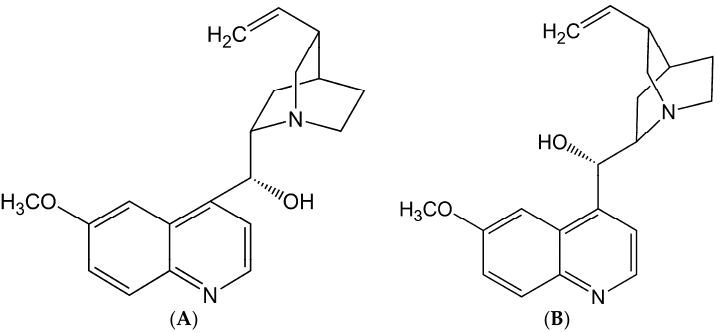
Figure 1. Chemical structure of quinine ( A ) and quinidine ( B ).